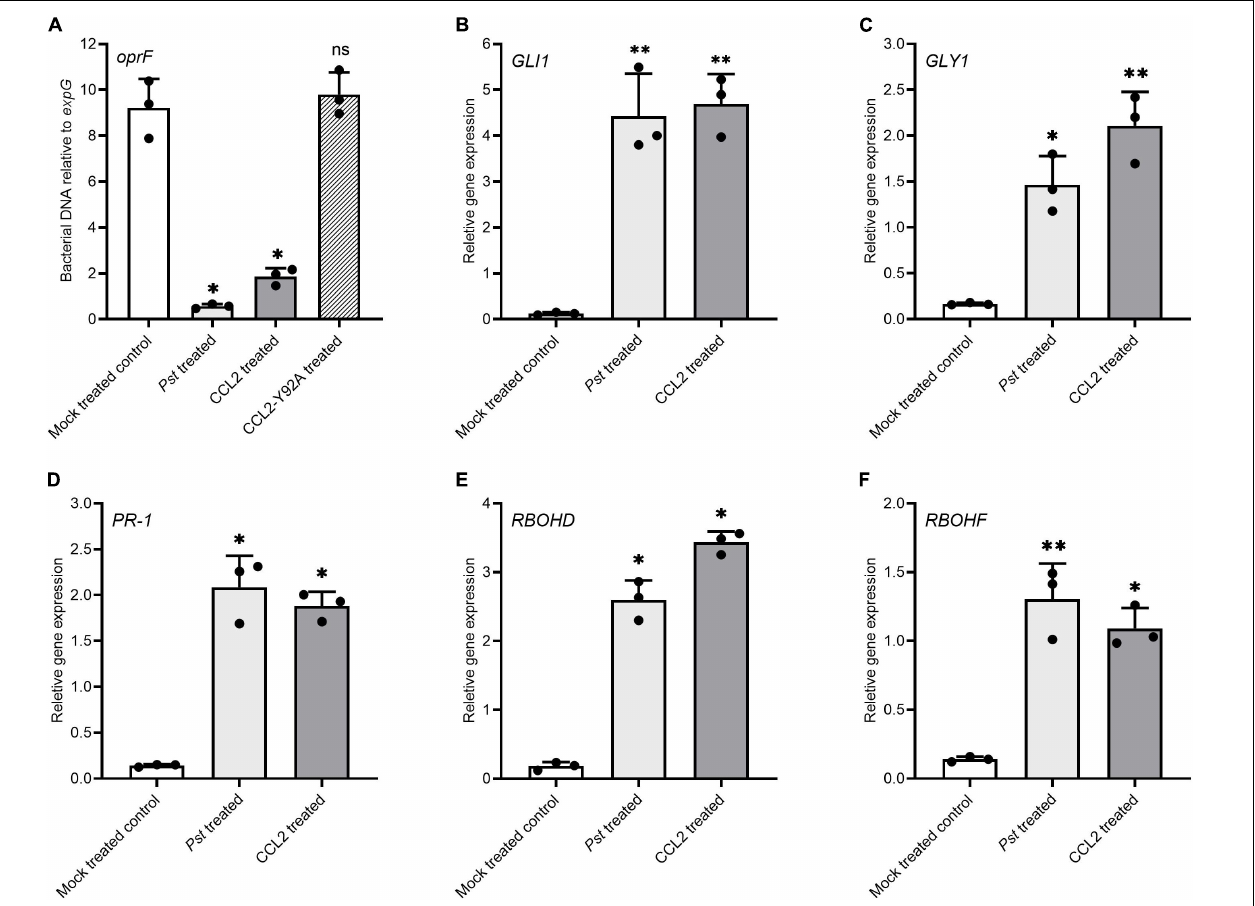
FIGURE 6 | Exogenous application of purified CCL2 induces defense gene expression and SAR toward P. syringae . Three leaves of 4-week-old wild type plants were infiltrated with 10 mM MgCl 2 (negative mock control), Pst DC3000 (10 6 CFU mL − 1 ) as positive SAR control, or 500 µ g mL − 1 of purified CCL2 or CCL2-Y92A protein, respectively. (A) Three distal leaves were challenge-inoculated with Pst DC3000 (10 5 CFU mL − 1 ) at 48 h after treatment. Ten leaf discs per treatment were sampled from distal leaves of Ten plants at 3 dpi to quantify by qPCR the abundance of the bacterial oprF gene as a proxy for bacterial biomass. (B–F) Transcript levels relative to expG gene in local leaves 48 h after treatment (B) GLI1 (AT1G80460), (C) GLY1 (AT2G40690), (D) PR-1 (AT2G14610), (E) RBOHD (AT5G47910), and (F) RBOHF (AT1G64060). Asterisks indicate statistically significant differences ( ∗ P ≤ 0.05, ∗∗ P ≤ 0.01, ns: not significant; one-way ANOVA and post hoc analysis with Dunnett’s multiple-comparison test) between treatments and mock control. Data represent mean ± SD of three biological